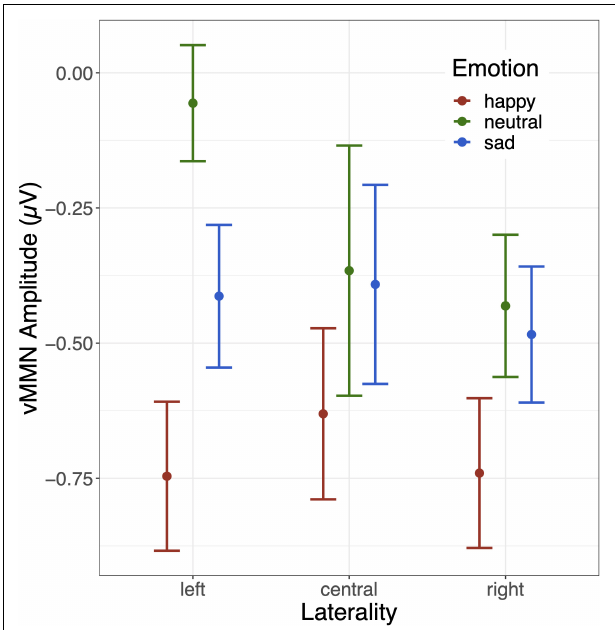
FIGURE 3 | Mean and standard error bars for the 3 (laterality: left [PO7, O1], central [Oz], right [O2, PO8]) × 3 (emotion: happy, sad, neutral) linear mixed effects